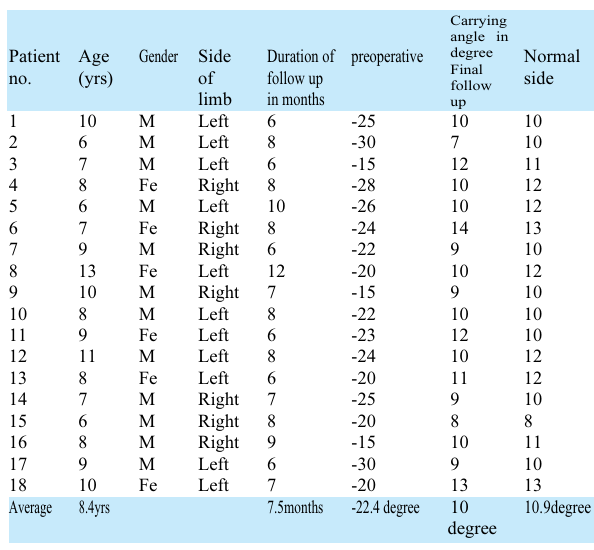
Table 1: Data on patients